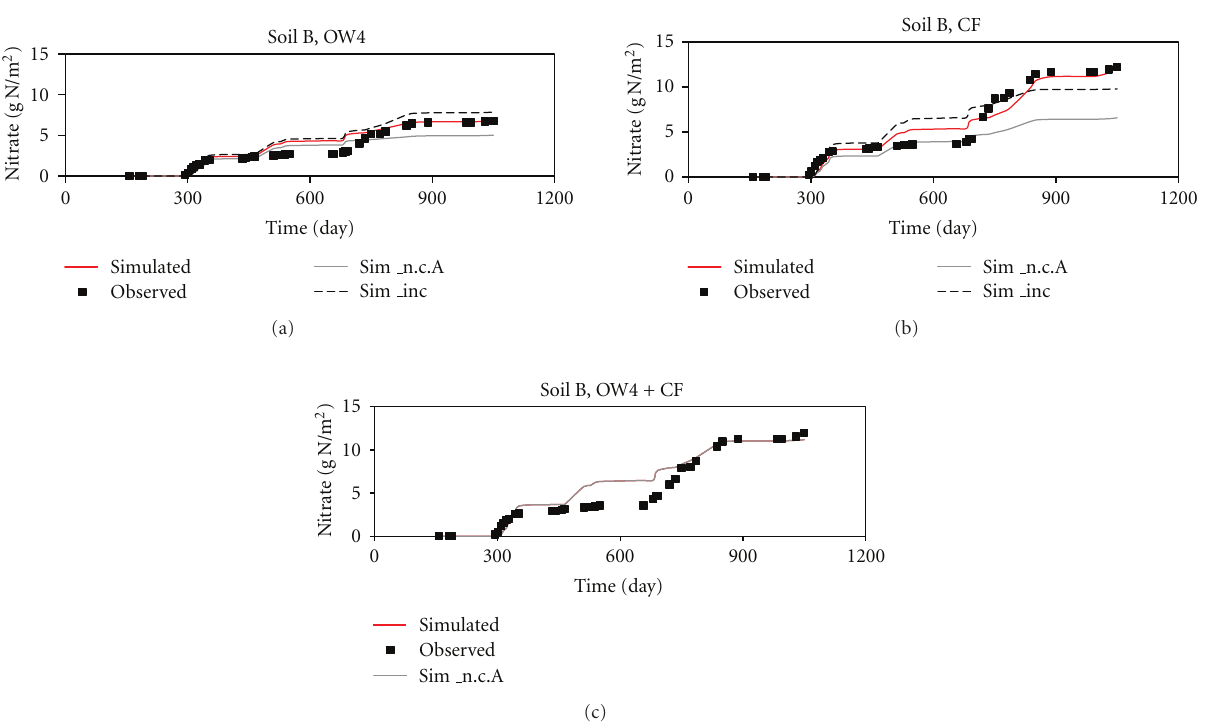
Figure 4: Application of organic matter to soil B. Simulated and observed NO 3 − -N leaching [gNm − 2 ] (accumulated values). Broken line indicates simulation with no calibration of management routine